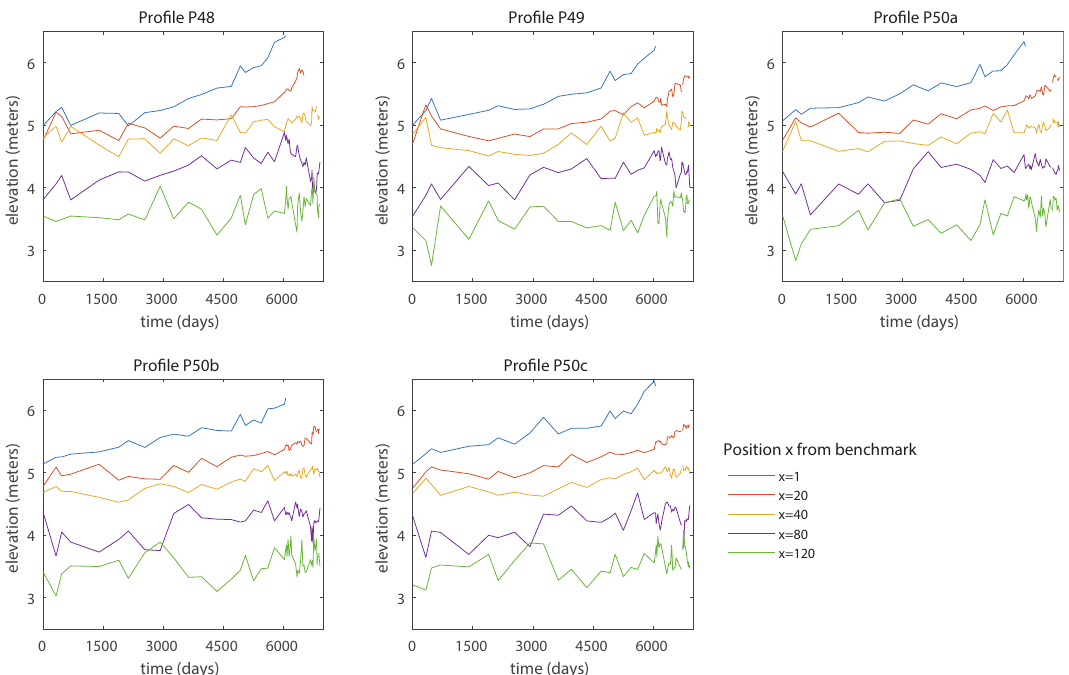
Figure 6. Time series of elevation at a set of chosen positions x along the Coastal Division cross-shore profiles (where x = 0 corresponds to the benchmark at the dune toe), showing that progradation (as quantified by the slope of the time series) mainly occurs close on the upper beach